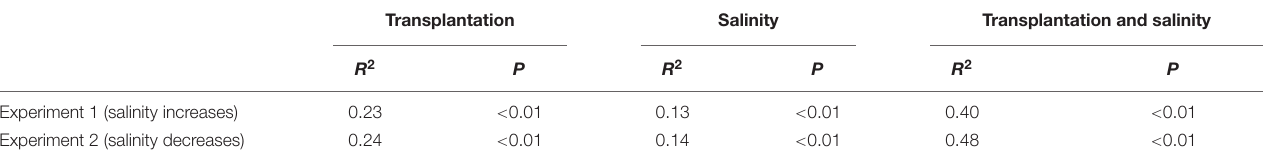
Transplantation Salinity Transplantation and salinity R